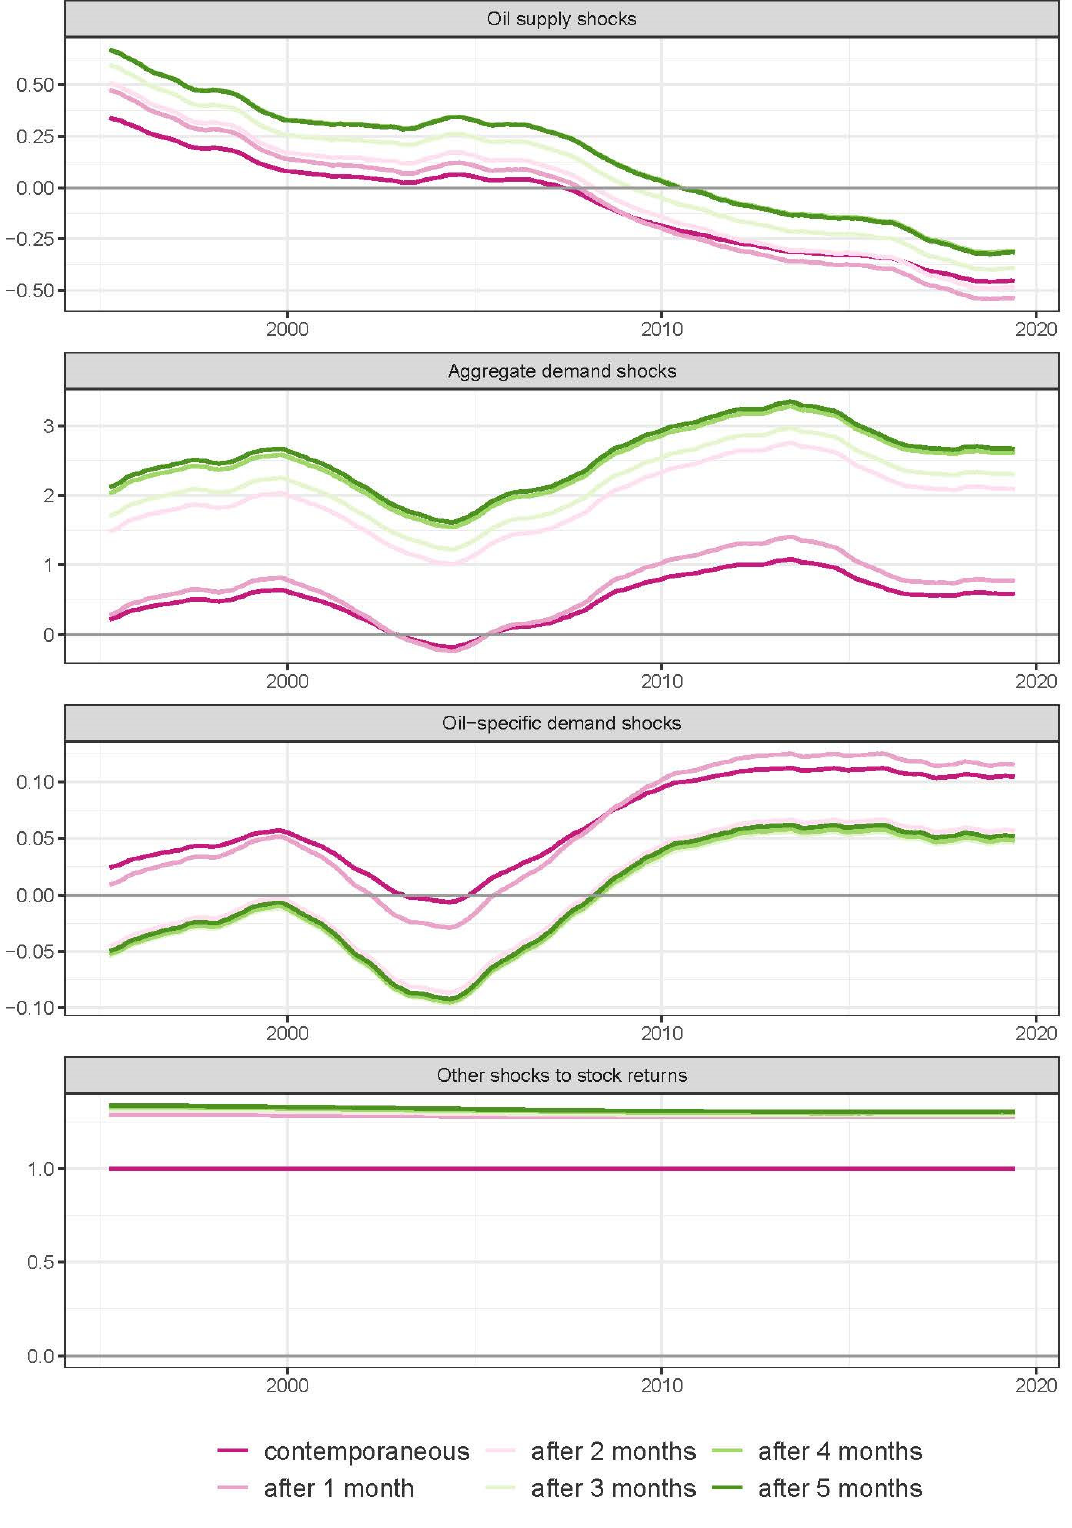
Figure 3. Responses of stock returns to structural shocks at different horizons. Note: This figure presents the accumulated responses of stock returns to a one-unit shock for each structural shock (1995:04–2019:06) after the first five months, as well as contemporaneously. It is worth mentioning that the supply-side shock refers to an unexpected increase in oil supply, the aggregate demand shock refers to an unanticipated expansion, and the oil-specific demand shock is related to an unexpected increase in oil-specific demand.